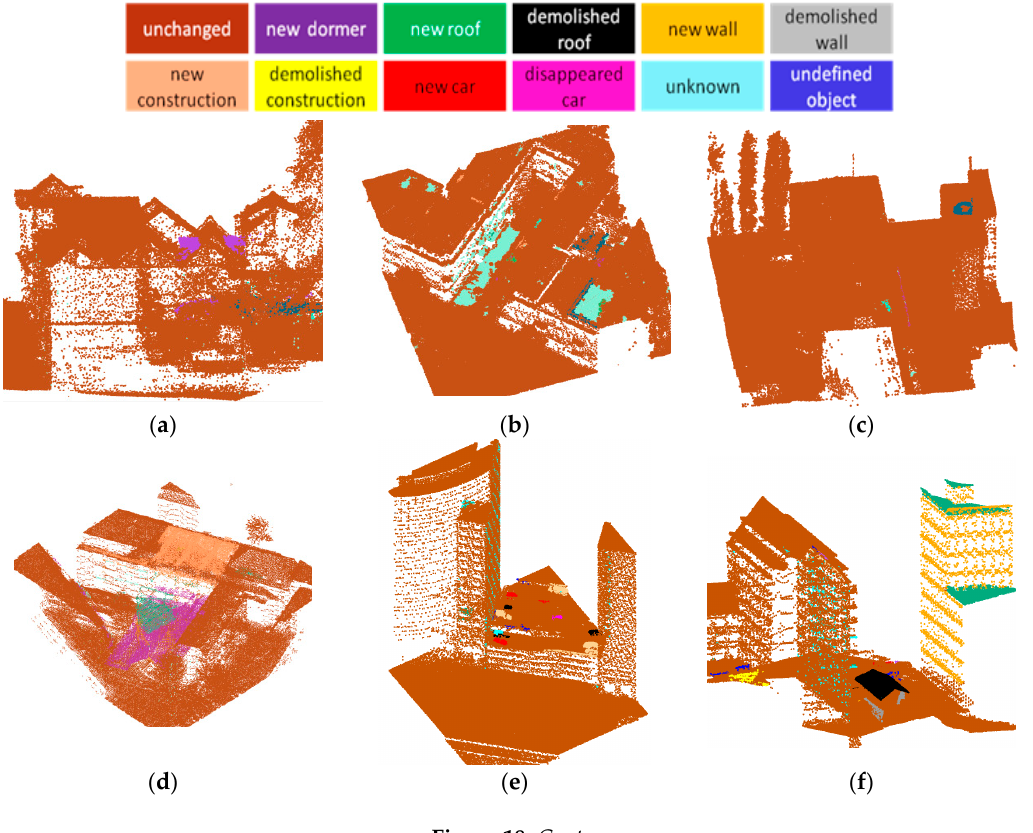
Figure 18. Cont. Figure 18. Cont